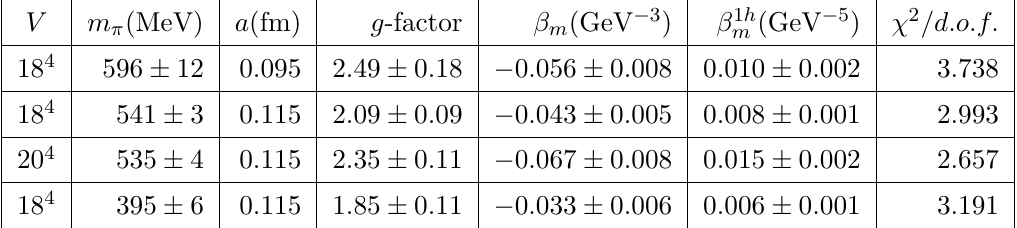
lines are the 4-parametric (cid:12)ts to the lattice data obtained with the use of formula (4.2), where m , g , (cid:12) and (cid:12) 1 h are the (cid:12)t parameters presented in table 6. These results agree m m but the g -factor values have bigger